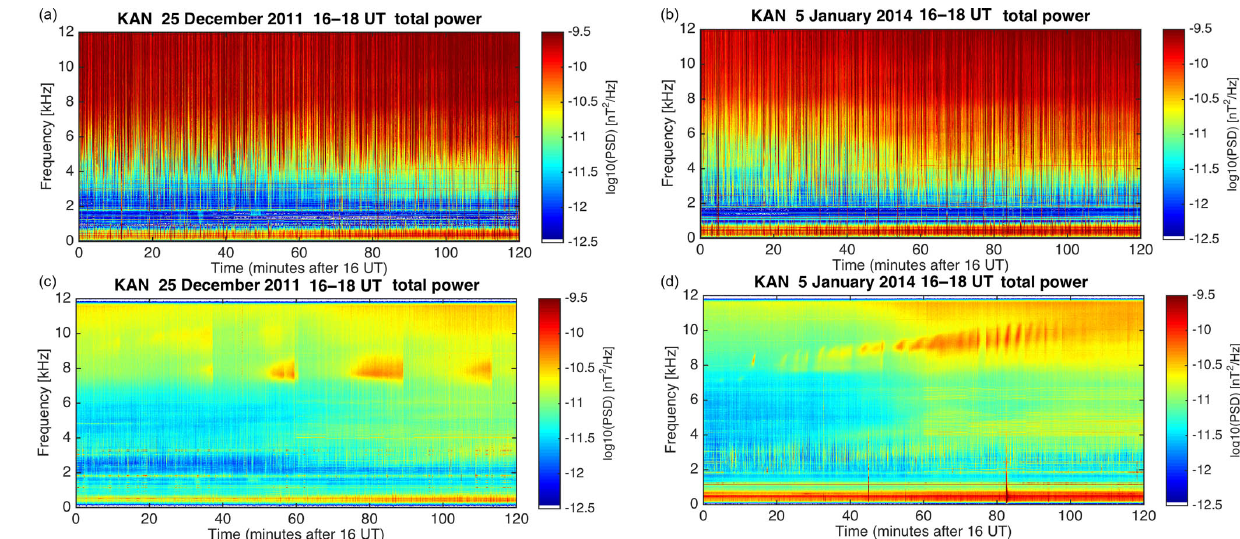
Figure 1. The 2h spectrograms of QP events observed on 25 December 2011 and 5 January 2014. Panels (a) and (b) show 0–12kHz spectrograms without sferics filtering, demonstrating that intense sferics hide all natural VLF emissions at frequencies above 4kHz. Panels (c) and (d) show the same intervals after filtering out the sferics, and previously unknown events revealed. Color bars shown in the right side represent the signal power (in log10(PSD), in nT 2 Hz − 1